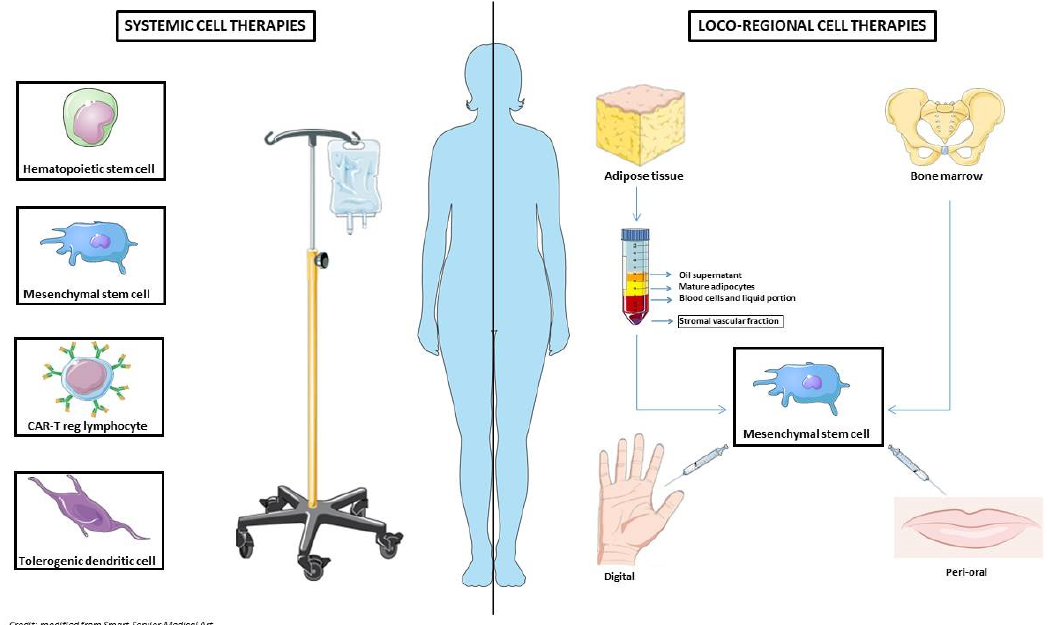
Figure 2. Cellular therapies might be adopted for both systemic and loco-regional use in patients with SSc. On the left side: systemic treatments including hematopoietic stem cell transplantation, mesenchymal stem cells, CAR-T cells and tolerogenic dendritic cells. On the right side: local treatments rely on mesenchymal stem cells obtained from adipose tissue or bone marrow successively engrafted to digits or perioral area.